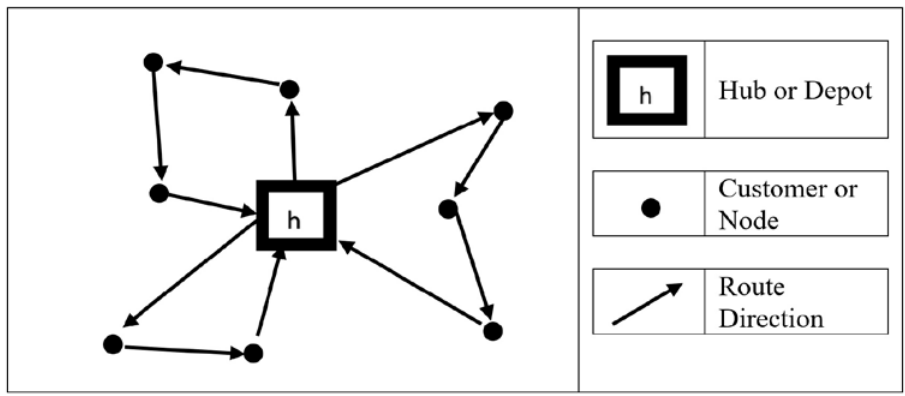
Figure 1. A portrayal of capacitated vehicle routing problem.